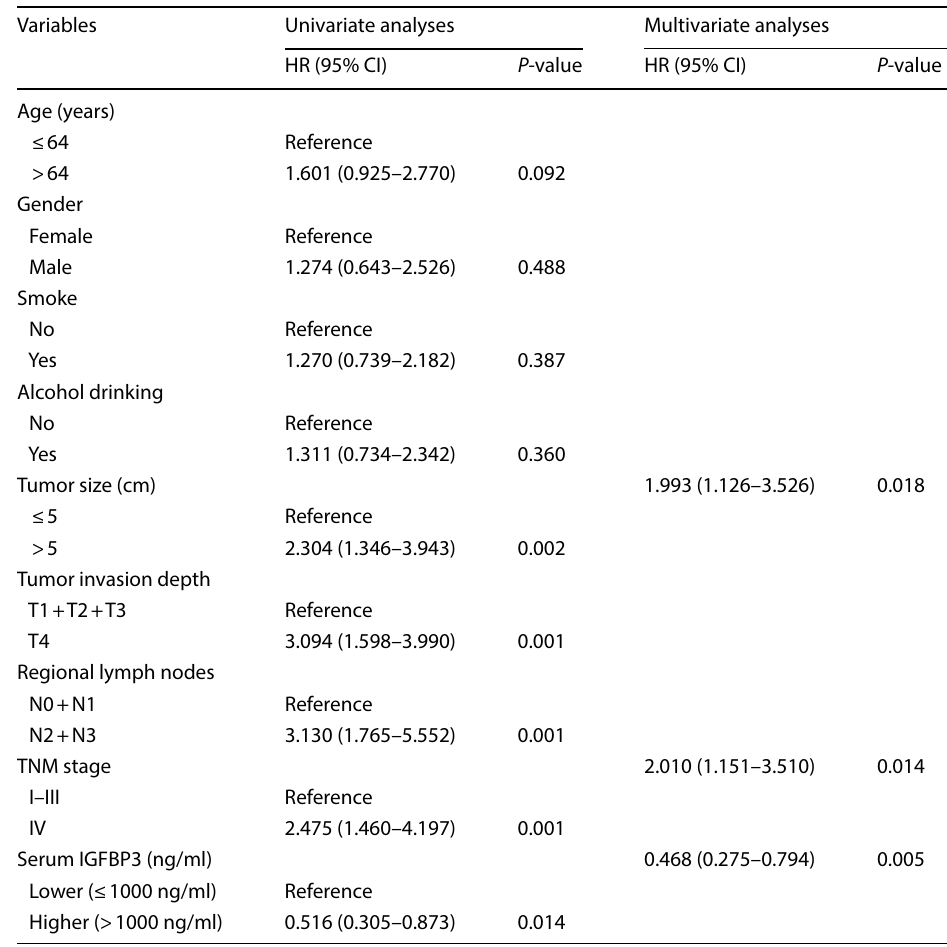
Table 3 Cox proportional hazards regression analysis of OS in EJA